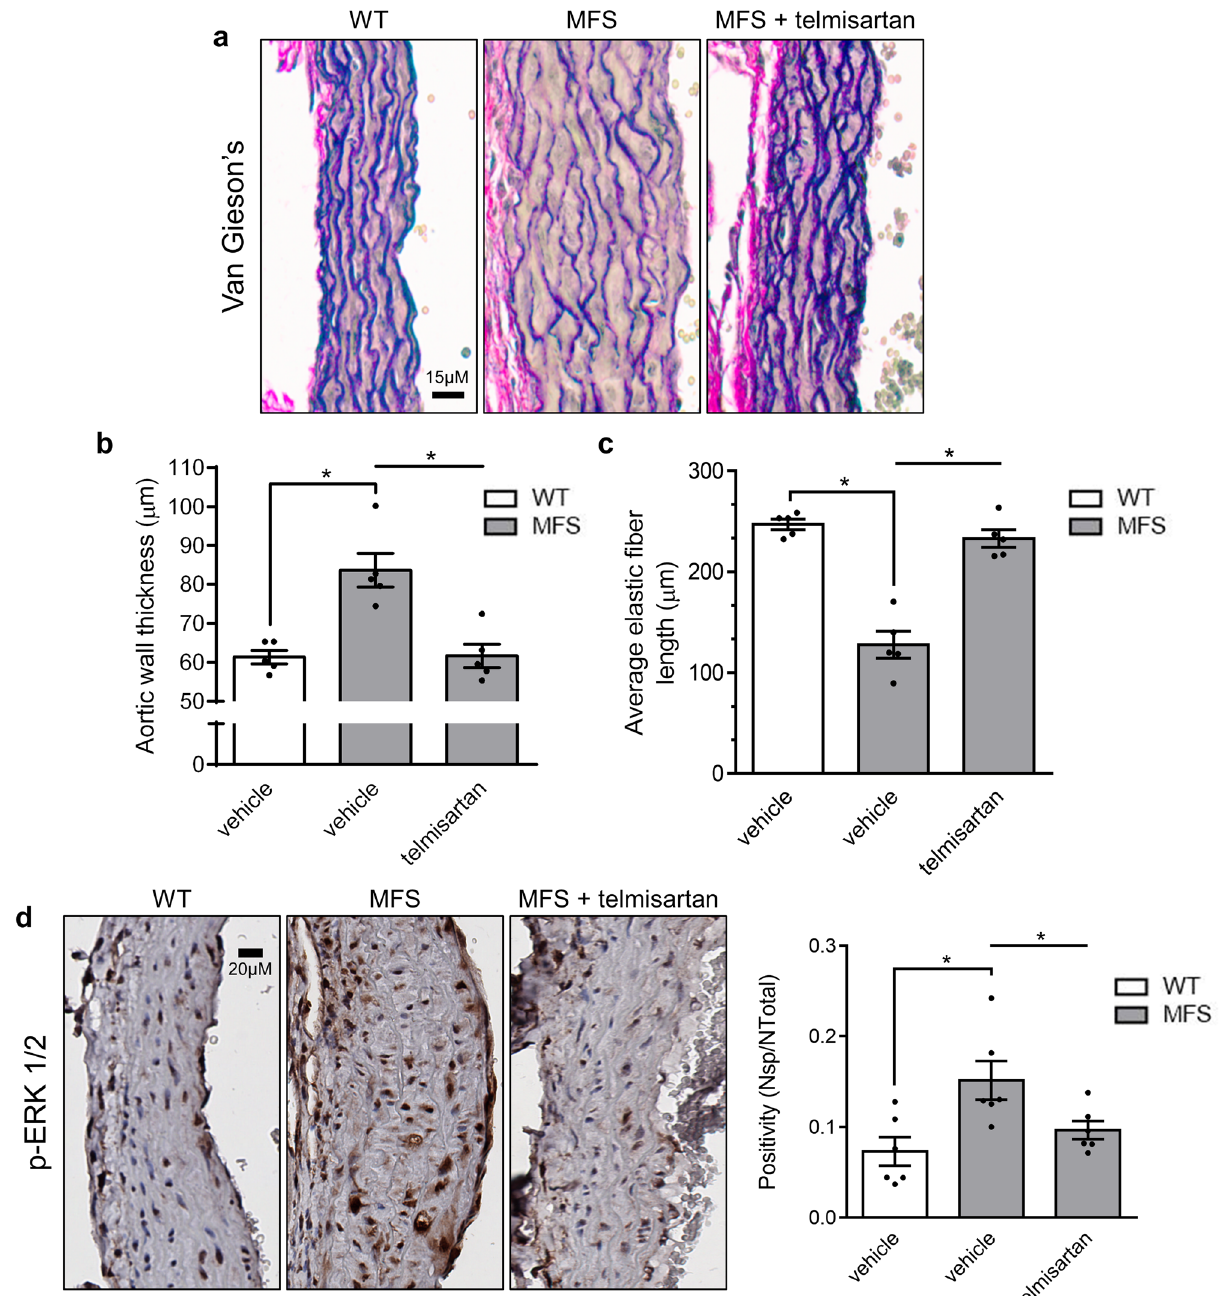
Figure 6. Telmisartan attenuates MFS-associated pathological remodeling and signalling in the aortic root of MFS mice. ( a ) Representative Van Geison’s staining of aortic roots of WT and MFS mice treated long-term with telmisartan. Treatment with telmisartan ( b ) decreases aortic wall thickness and ( c ) increases average length of elastic fibers in the aortic root of MFS mice. (WT n = 5, MFS n = 5, MFS + telmisartan n = 5) ( d ) Representative p-ERK ½ staining, and average quantification of aortic roots of WT and MFS mice treated long-term with telmisartan. (WT n = 6, MFS n = 6, MFS + telmisartan n =